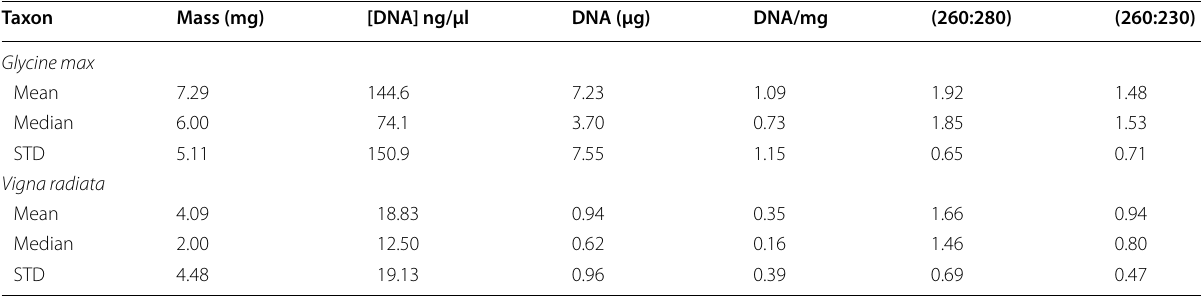
Table 1 The mean root nodule dry-mass and the respective mean concentration, and 260:280 and 260:230 absorbance ratios of the DNA extracts for Glycine max cv. Tara and Vigna radiata cv. Crystal Taxon Mass (mg) [DNA] ng/µl DNA (µg) Glycine max Mean